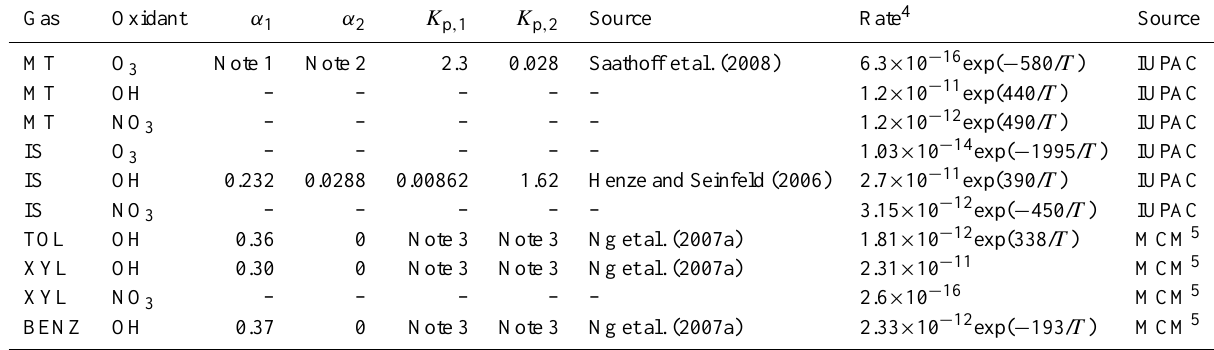
Table 1. SOA reaction rates and two-product parameters. MT: monoterpenes, IS: isoprene, TOL: toluene, XYL: xylene, BENZ: